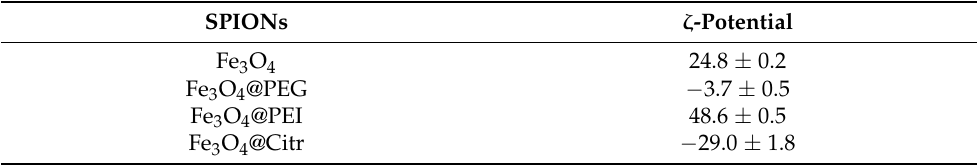
Table 4. ζ -Potential of synthesized SPIONs ( n =